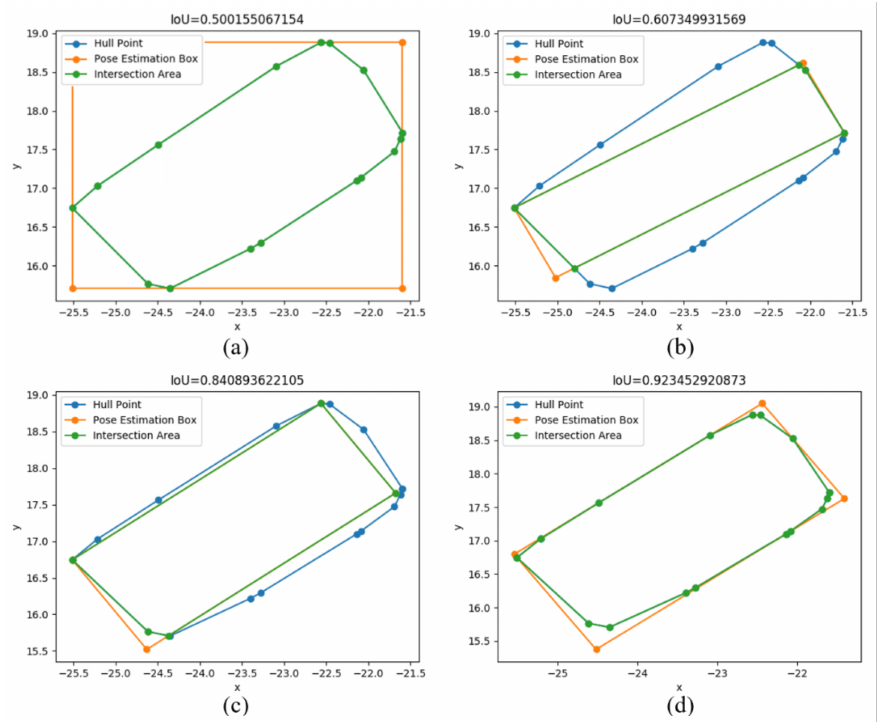
Figure 20. The evaluation of the P-IoU index. The ( a – d ) show four different pose estimation methods’ results for the same obstacle vehicle. For the same obstacle, the higher the value of the P-IoU, the more accurate the pose estimation